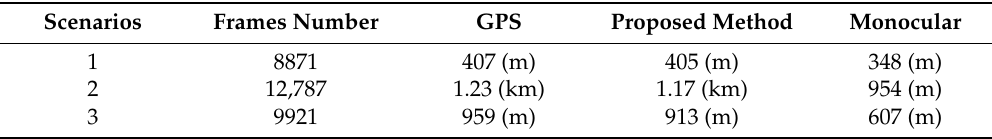
Table 2. Measured distance of the movement for different methods.